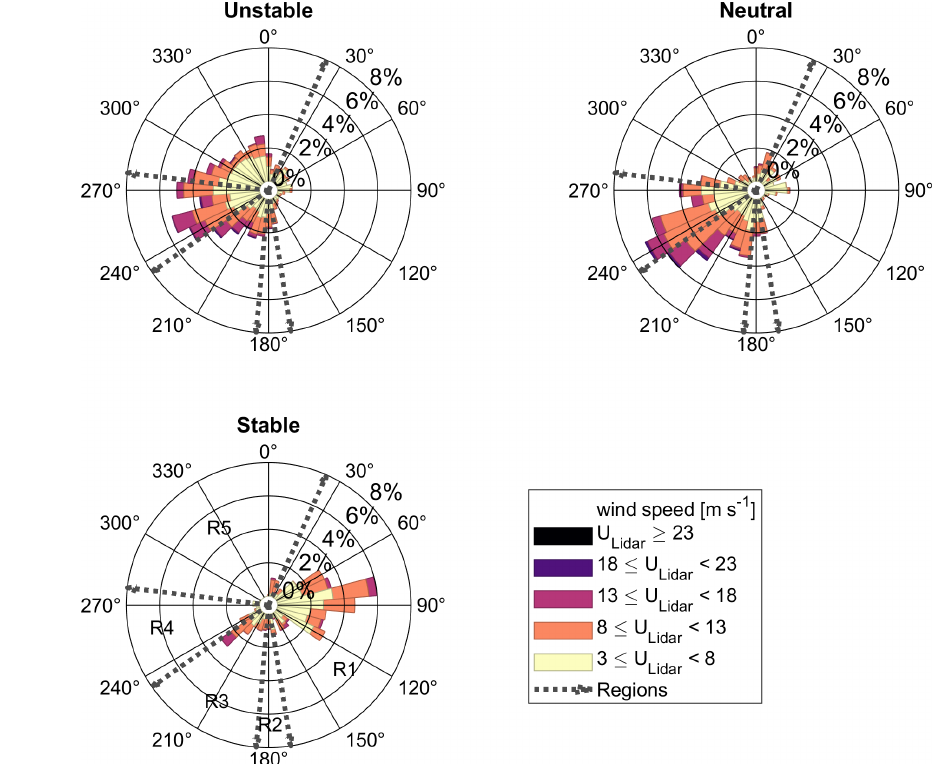
Figure 11. Wind roses measured by the scanning lidar for different atmospheric stabilities at 120m above LAT. The regions R1–5 are indicated by dashed